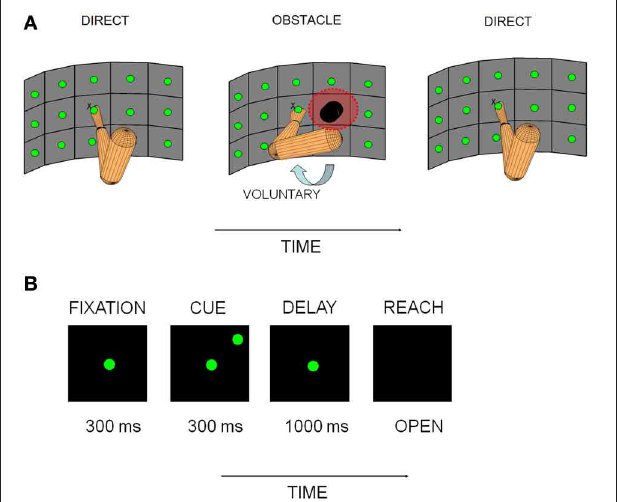
FIGURE 1 | Experimental apparatus and behavioral paradigm. (A) Vertically oriented array of pushbuttons used to cue reaches is illustrated for each experimental block, along with a schematic representation of the starting posture of the arm. The posture change shown in the obstacle avoidance block (OA) represents an approximation of the anticipatory change in initial arm posture that the sensors registered. (B) Sequence of events on single trials. The experimental paradigm consisted of a baseline/fixation epoch (300ms), followed by cue (300ms), delay/memory (800–1000 ms) and reach epochs (variable duration as movement time was not